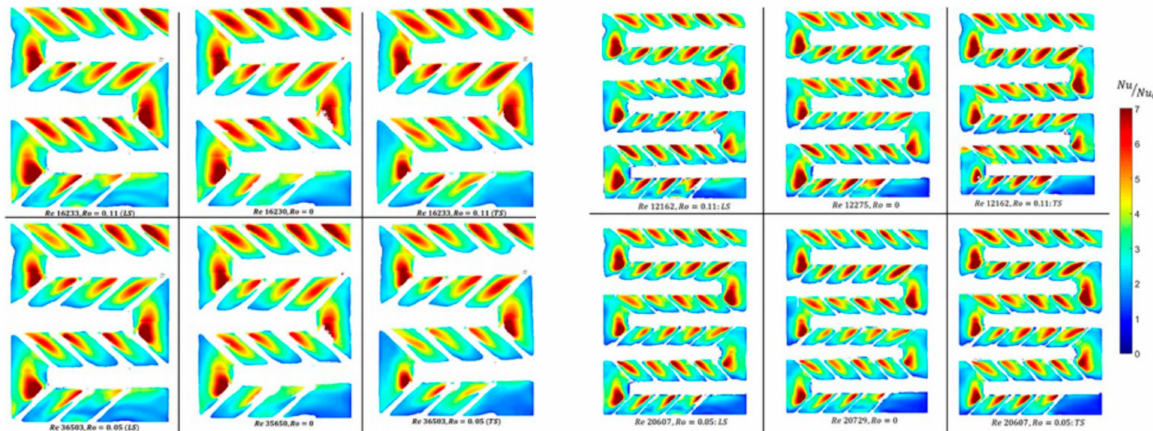
Figure 19. Parallel rotation multi-passage ribbed configurations proposed by Singh et al. [72]. Reprint with permission from ASME (order number